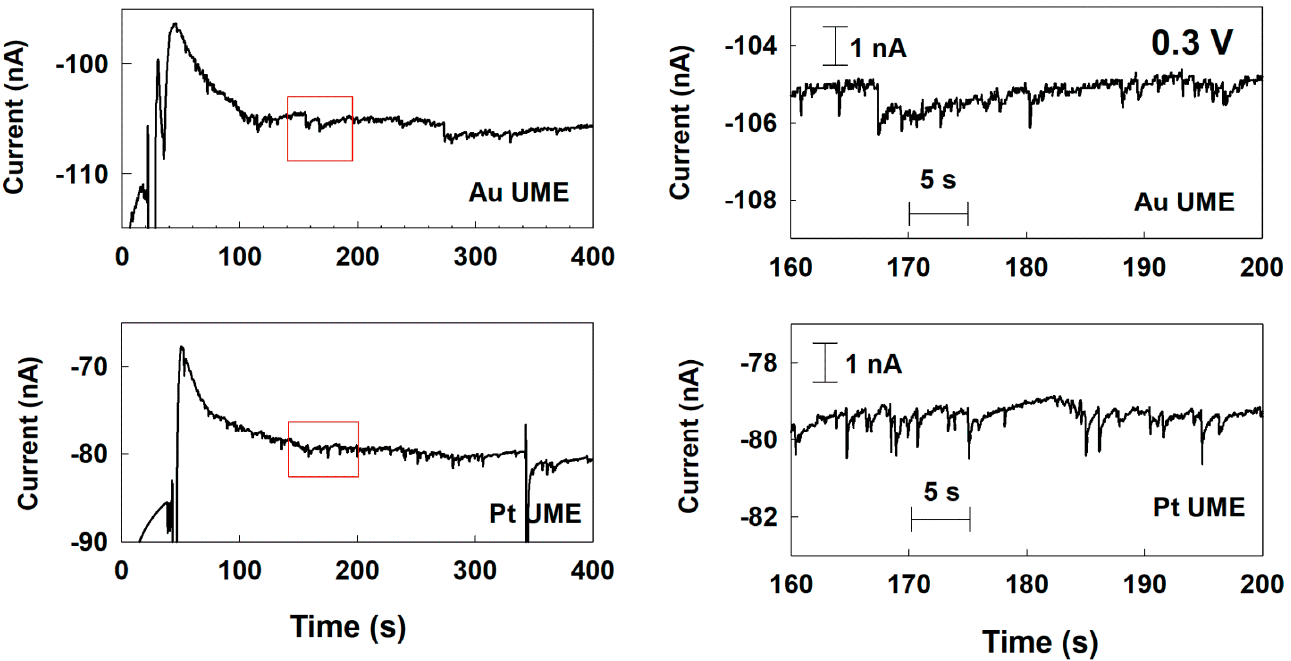
Figure 4. Chronoamperometric curves for a single-Pd-NP collision at Au and Pt UMEs with a potential of 0.3 V (vs. Ag/AgCl) applied in a 50 mM phosphate buffer (pH 6.8) containing 15 mM hydrazine. The Pd NP concentration was 160 pM. The data acquisition time was 50 ms.